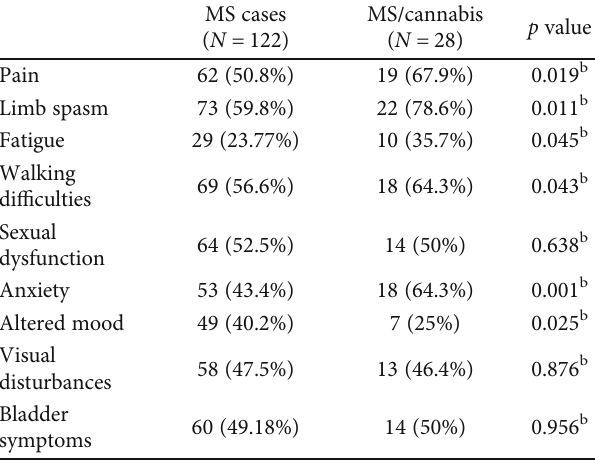
Table 4: Analysis of symptom improvement in cases with MS.